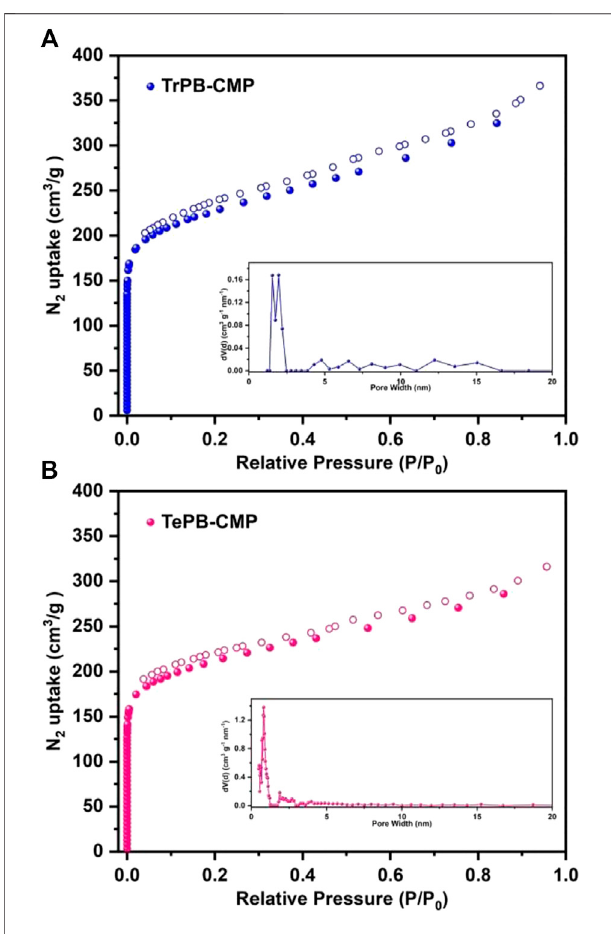
FIGURE 2 | Nitrogen adsorption and desorption isotherms of TrPB- CMP (A) and TePB-CMP (B) and simulated pore size distributions of CMPs (insets) at 77